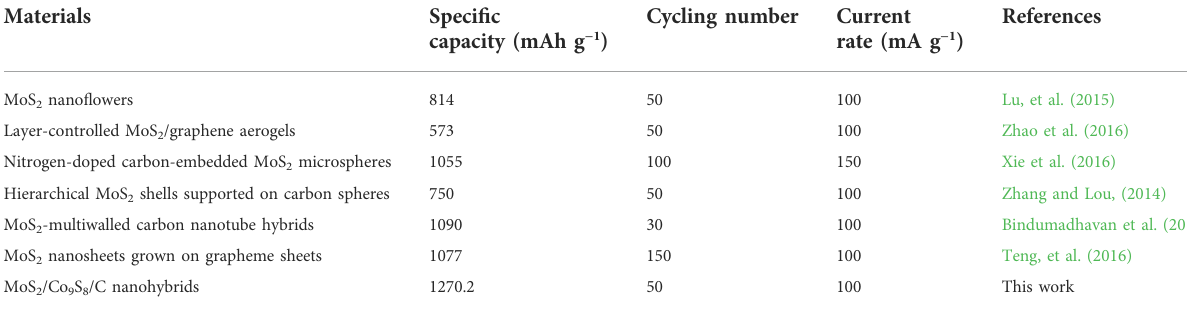
TABLE 1 Lithium storage performances of the present MoS 2 /Co 9 S 8 /C with the reported MoS 2 -based anode